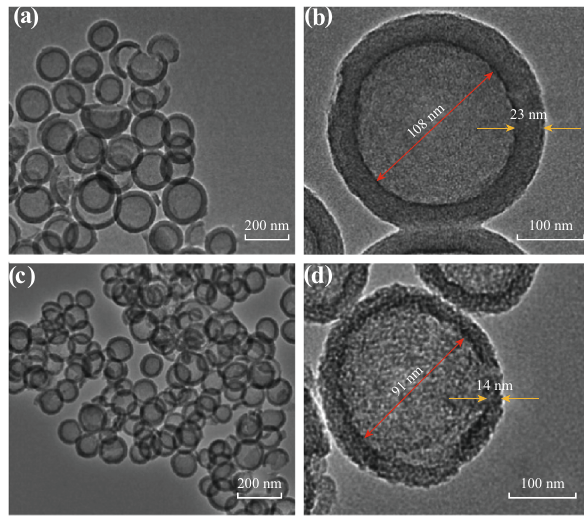
Fig. 4 TEM images of a – b NHCSs and c – d